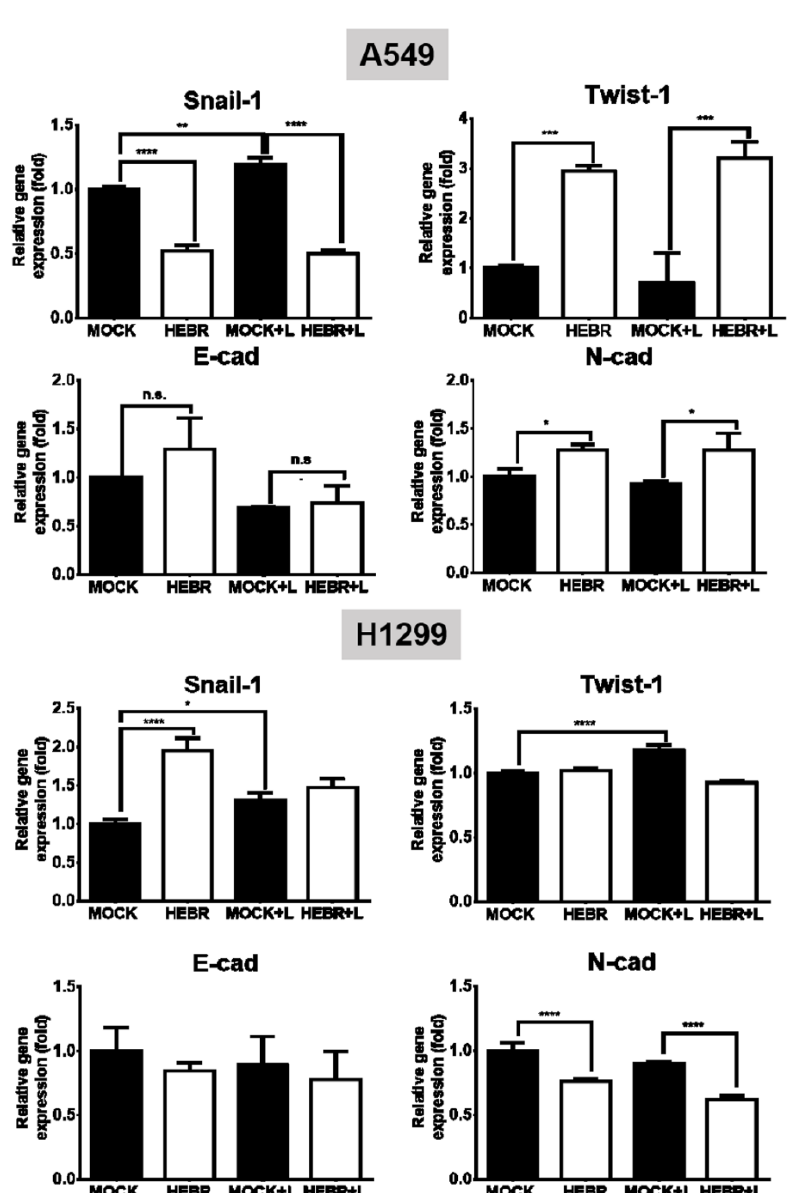
Figure 5. Gene expression of EMT HEBR treatment in A549 and H1299 cells. The cells were treated with HEBR proteins for 72 h with and without green-light illumination. The gene expression levels of markers for EMT, including Snail-1, Twist-1, E-cad, and N-cad, were analyzed for A549 or H1299 cells by qRT-PCR and calculated by GraphPad Prism 5 software. The expression of each marker was normalized to that of GAPDH in each group and then presented as the relative expression level to the mock group. L: treated with green-light illumination. Asterisks indicate statistically significant differences, * p ≤ 0.05, ** p ≤ 0.01, *** p ≤ 0.001, **** p ≤ 0.0001.